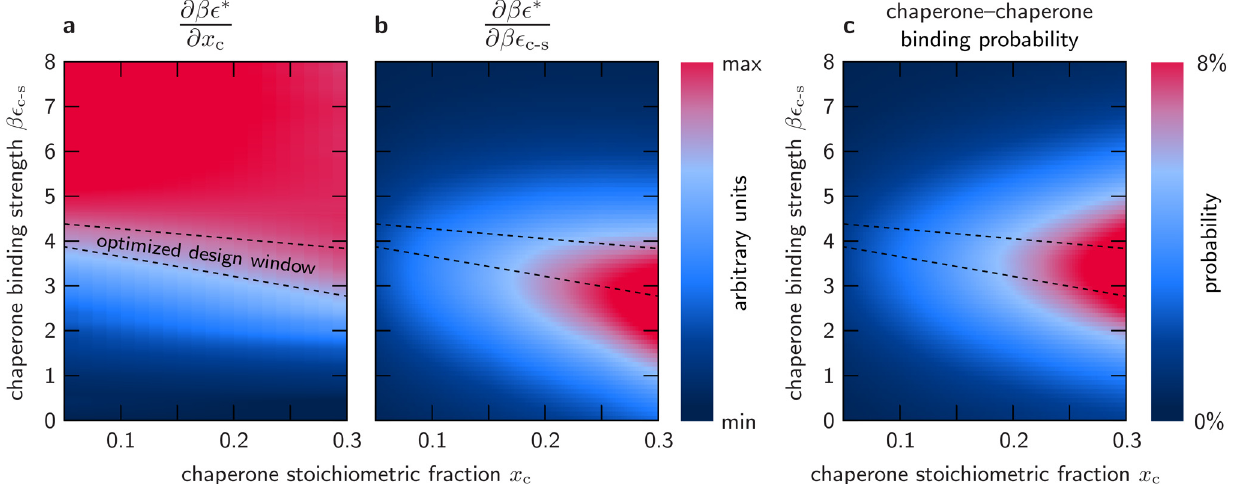
Fig 3. The optimized design window for a passive molecular chaperone coincides with the conditions under which chaperone oligomerization is most probable. (a) The response in the solution miscibility limit to an increase in the chaperone stoichiometric fraction. The approximately linear response regime for strong binding chaperones is indicated in red. (b) The response in the solution miscibility limit to an increase in the chaperone – client binding strength. (c) The probability that a chaperone binding interface is bound to another chaperone monomer. For a given stoichiometric ratio of chaperones and clients, this probability is greatest in approximately the same design window in which both @ β (cid:1) * / @ x c and @ β (cid:1) * / @ β (cid:1) c-s are simultaneously